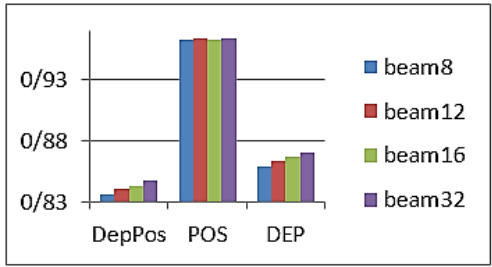
Figure 3. Study of relationship between beam size and accuracy on Persian.